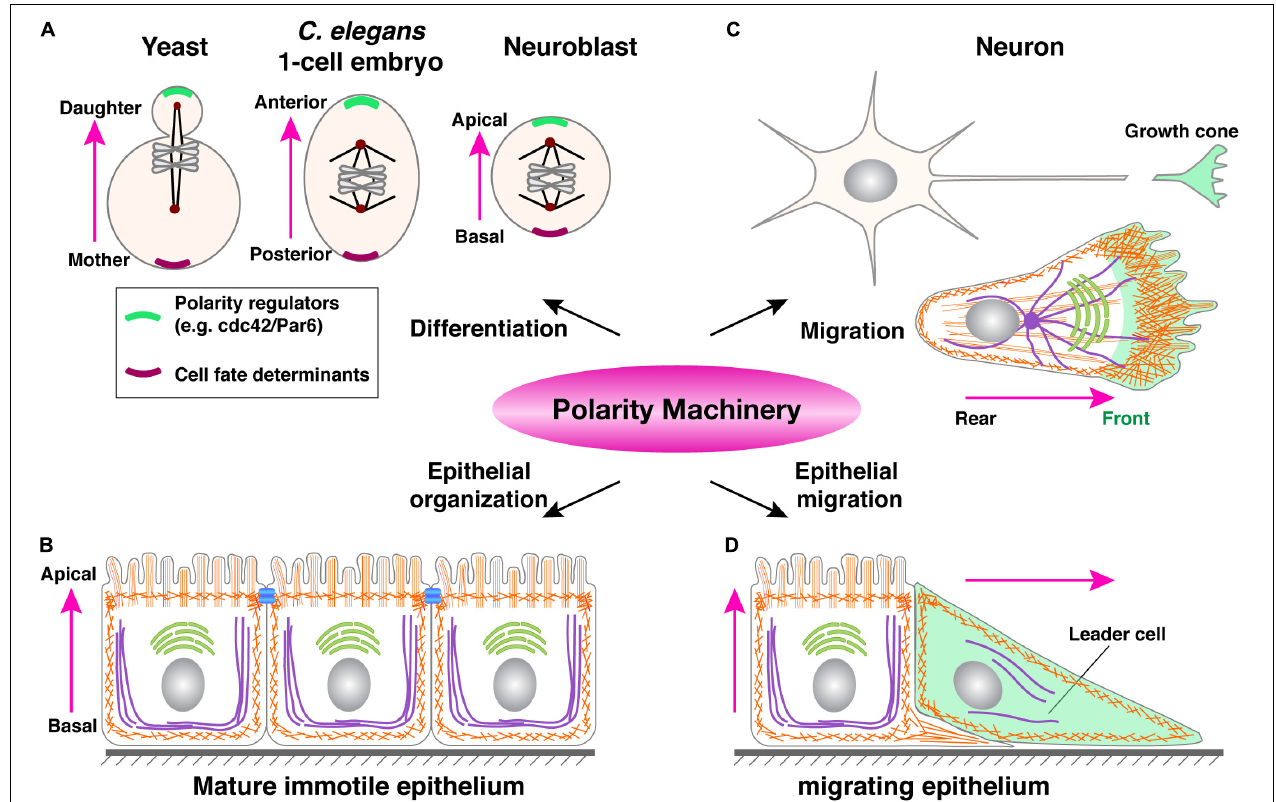
FIGURE 4 | A common polarity machinery regulates distinct cell behavior. (A) Yeast cell division, anterior-posterior determination during one-cell stage embryo development of C. elegans , and neuroblasts differentiation can all be viewed as different forms of cell fate determination. They all involve the asymmetric distribution of cell fate determinants (purple) upon polarity determination by regulatory machinery (green). (B) Mature immotile epithelium whose most salient feature is apicobasal polarity, as indicated by cell morphology and the presence of tight junctions (blue bars). (C) A migrating single cell, whose front is colored in green.